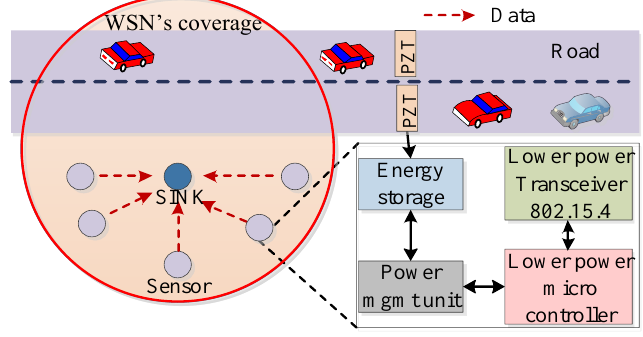
Figure 12 Moving vehicles-based EHWSN architecture. Figure 12. Moving vehicles-based EHWSN